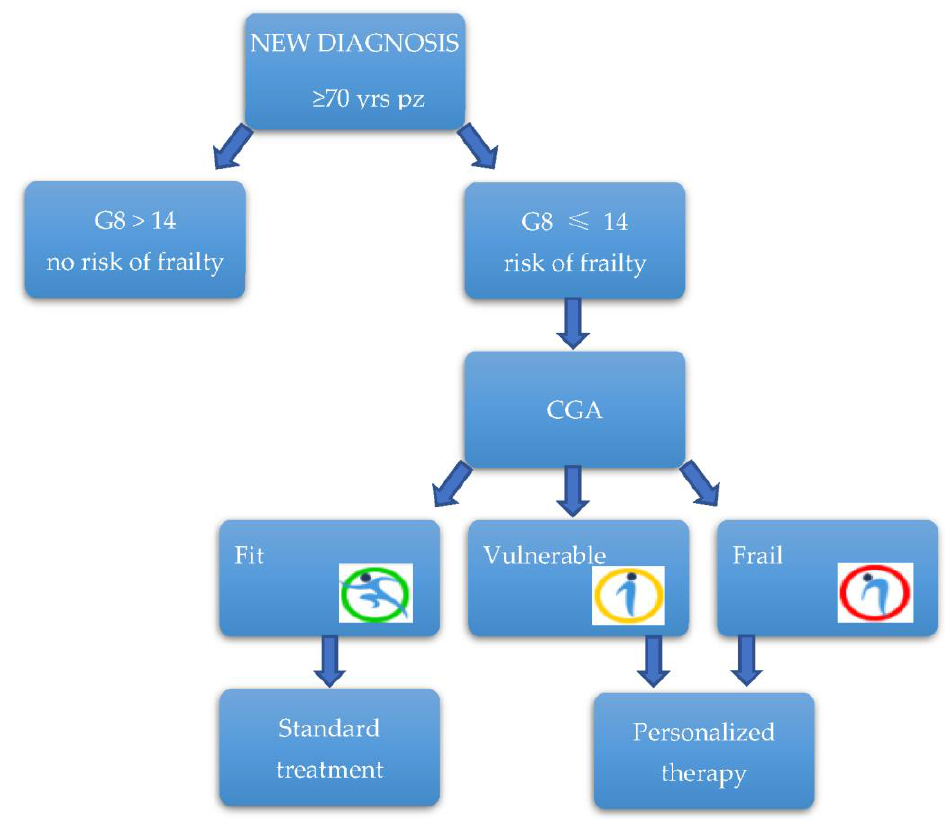
Figure 1. Patients flow. Table 2. The comprehensive geriatric assessment used in our